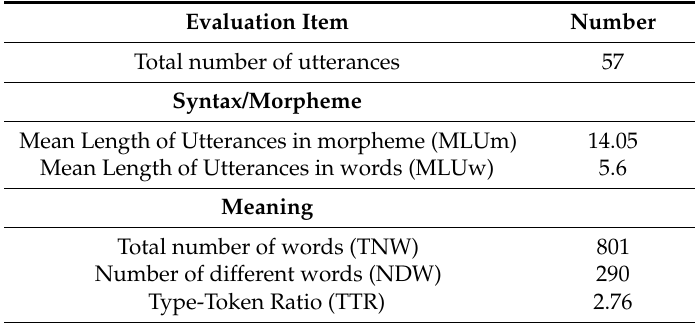
Table 1. Example of the analysis results from a single transcription